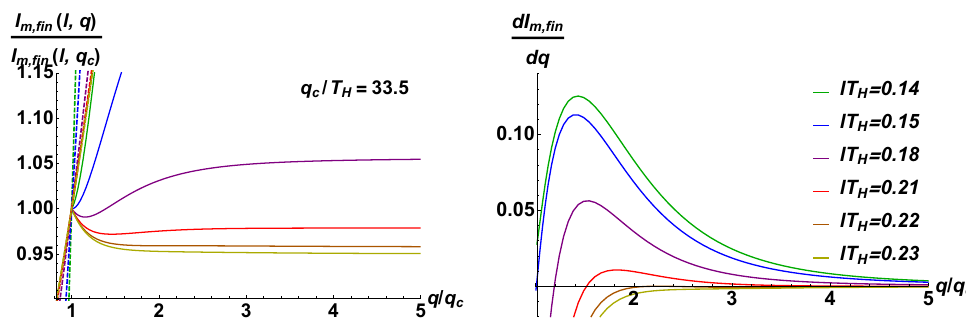
Figure 5 . Normalized entanglement entropy as a function of q=q c for 6 di(cid:11)erent invariant sub- system sizes lT H (from top to bottom, lT H = 0 : 14 ; 0 : 15 ; 0 : 18 ; 0 : 21 ; 0 : 22 ; 0 : 23) with a (cid:12)xed temperature T H = 0 : 15 and g 2 = 10. The dashed and solid curves are for uncondensed and YM condensed phases, respectively.